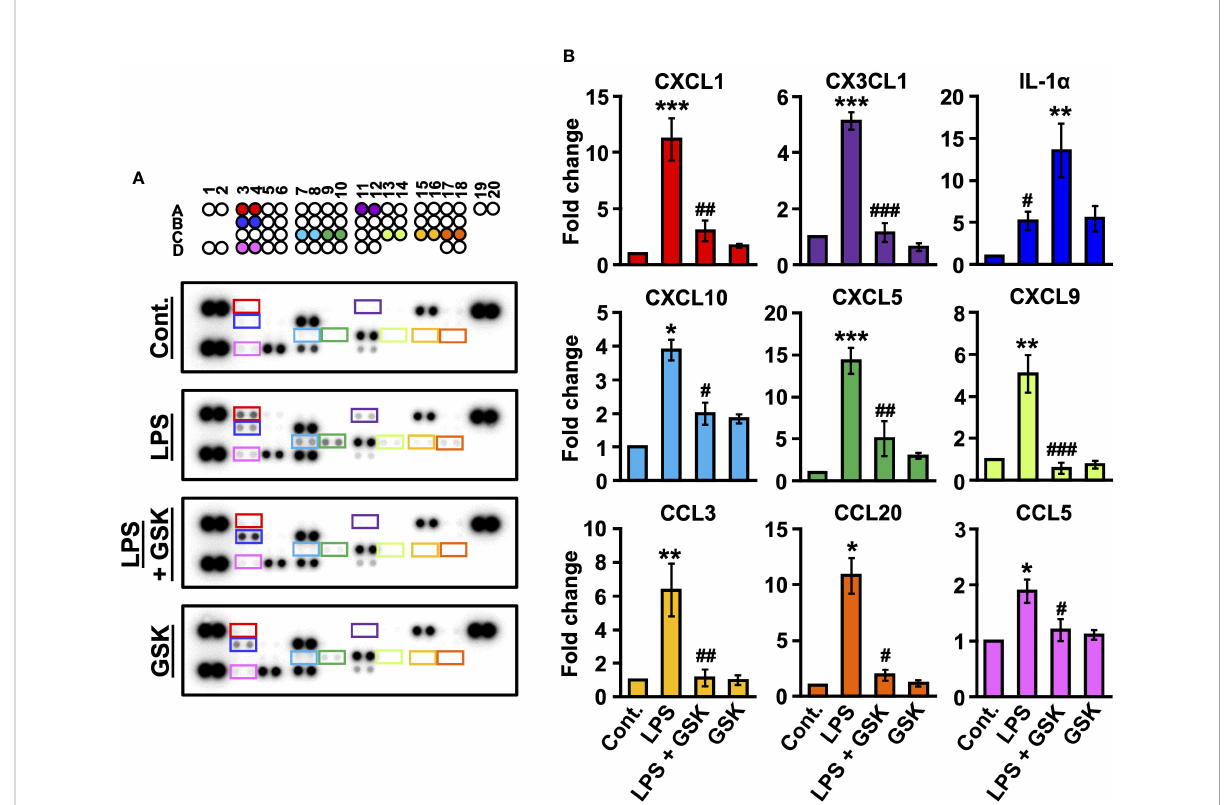
FIGURE 4 Changed secretion of LPS-induced in fl ammatory cytokines by GSK in rat bladder. (A) Raw images of the cytokine array for each group. (B) Fold change was calculated relative to the control. Data represent the mean ± SEM; n = 3 for each group. * P < 0.05, ** P < 0.01, *** P < 0.001 vs control. # P < 0.05, ## P < 0.01, ### P < 0.001 vs LPS or LPS +